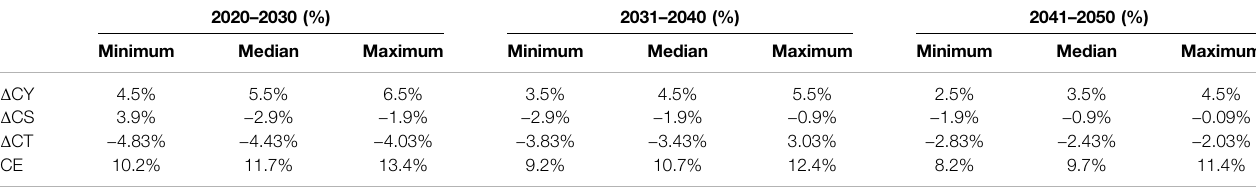
TABLE 9 | Potential change rate of each in fl uencing factor under the low-carbon